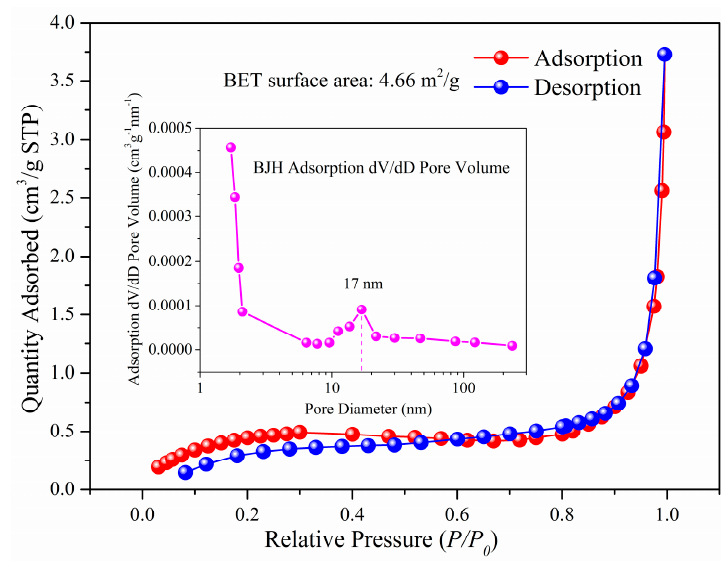
Figure 7. N 2 adsorption-desorption isotherm of α -Fe 2 O 3 @C nanoparticle composite. The insert is BJH pore size distribution.